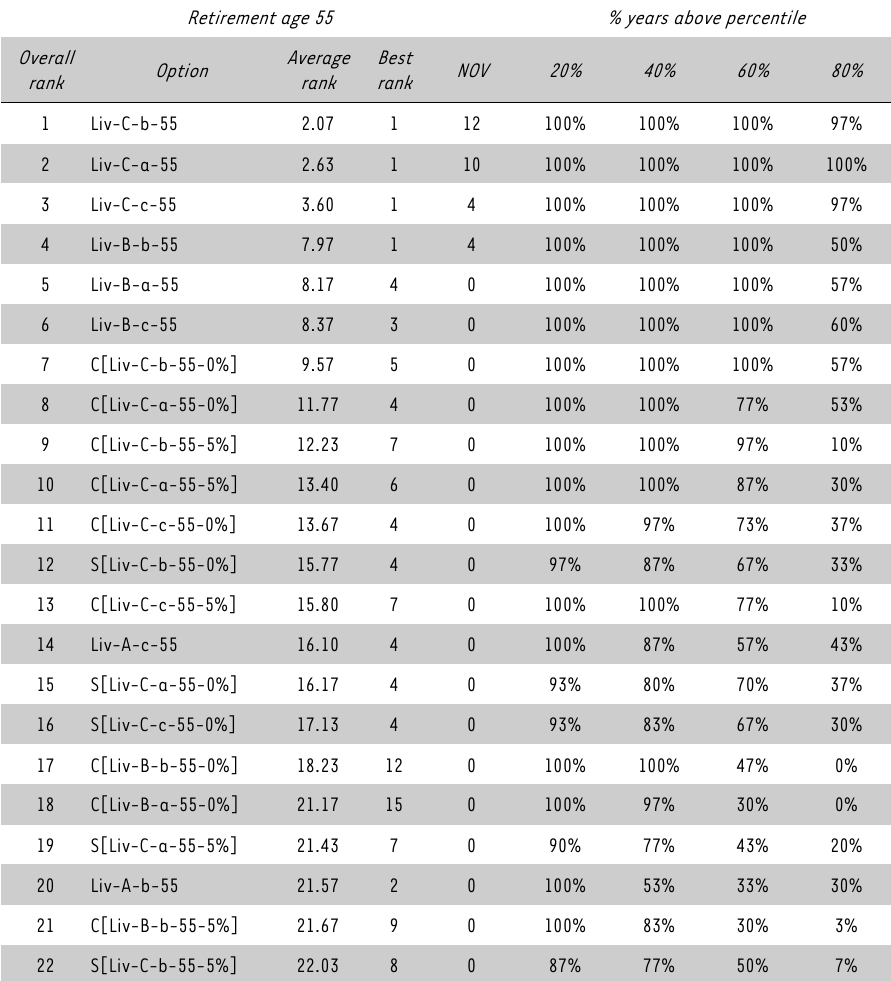
TABLE 2: All annuity strategies ranked by average rank for a male retiree aged